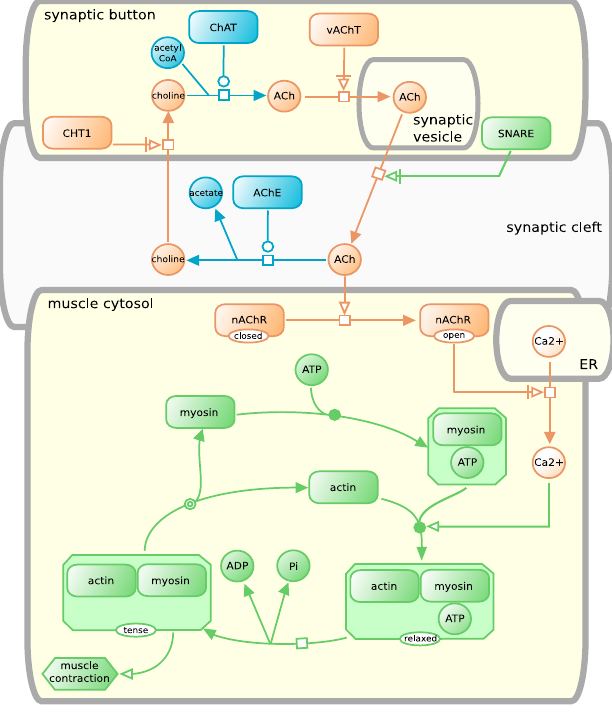
Figure A.4: Neuronal/Muscle signalling. A description of inter-cellular signalling using SBGN.